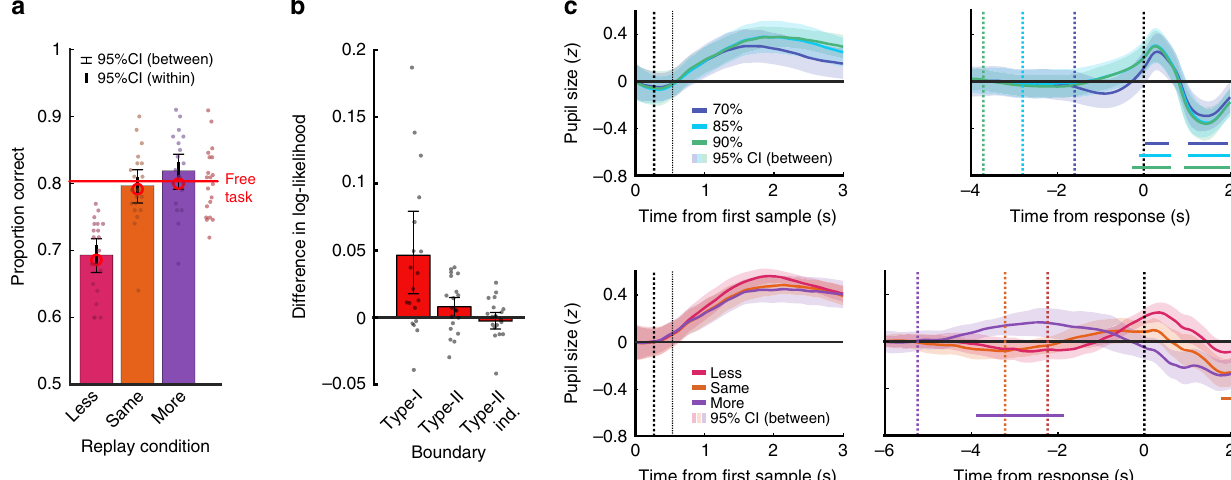
Fig. 4 Evidence for a covert bound on Type-I evidence accumulation. a Average proportion correct in each condition of the Replay task. In the Same condition (orange), observers were shown the same number of samples as they had chosen to respond to in the Free task, in the Less condition (magenta) they were shown two fewer samples, and in the More condition (purple), four additional samples. The red horizontal line shows the average proportion correct in the Free task, where the exact same trials were shown (with the exception of the condition manipulation). Error bars show 95% within-subject (thick) and between-subject (thin) con fi dence intervals ( n = 20). Open red circles show the model predictions based on simulations of the bounded model. b Difference in log-likelihood (relative improvement in fi t) between the model fi t with a covert boundary compared to the model without. The bars show the improvement in the fi t to Type-I responses with a bound on Type-I evidence accumulation (labelled Type-I), the improvement in the fi t to Type-II responses when the Type-II is bounded at the same time as the Type-I evidence (labelled Type-II), and the improvement in the fi t to Type-II responses when an independent bound is fi t to the accumulation of Type-II evidence (labelled Type-II ind.). Error bars show 95% between-subject con fi dence intervals n = 20. c Standardised pupil size in the Stopping task (top) and Replay task (bottom), averaged across time-windows aligned to the start of each trial (left) and to the response (right). Shading shows 95% between-subjects con fi dence intervals ( n = 19). Trial-start aligned data were baselined to the average at time 0, response-aligned data were baselined to the average prior to trial start ( − 4 to − 3 s in the Stopping task, and − 6 to − 5 s in the Replay task). Black vertical lines in the trial-start plots show the timing of the 2nd and 3rd samples. Vertical lines in the response plots show the average median timing of the start of the trial. Differences from baseline in the response-aligned epochs were tested using two-sided Wilcoxon sign rank tests, with signi fi cant clusters shown with horizontal lines (corrected p <